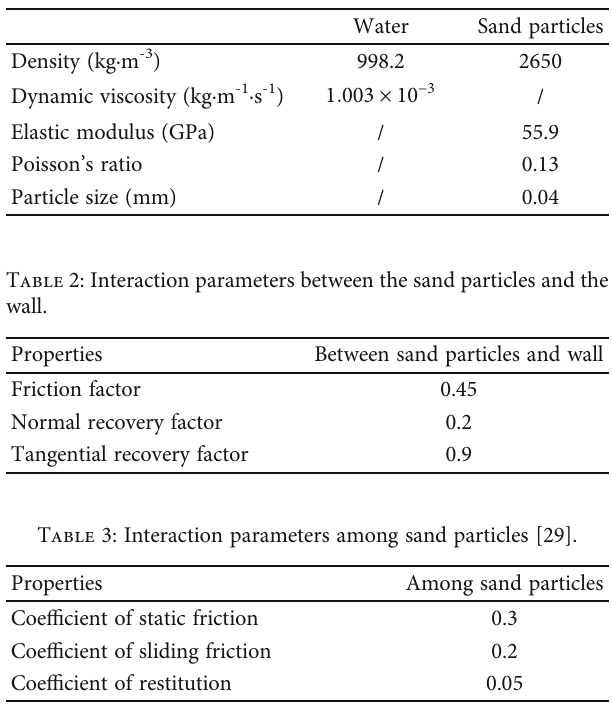
Figure 5: Grids in the boundary layer of the rough fracture. Table 1: Material properties [29].